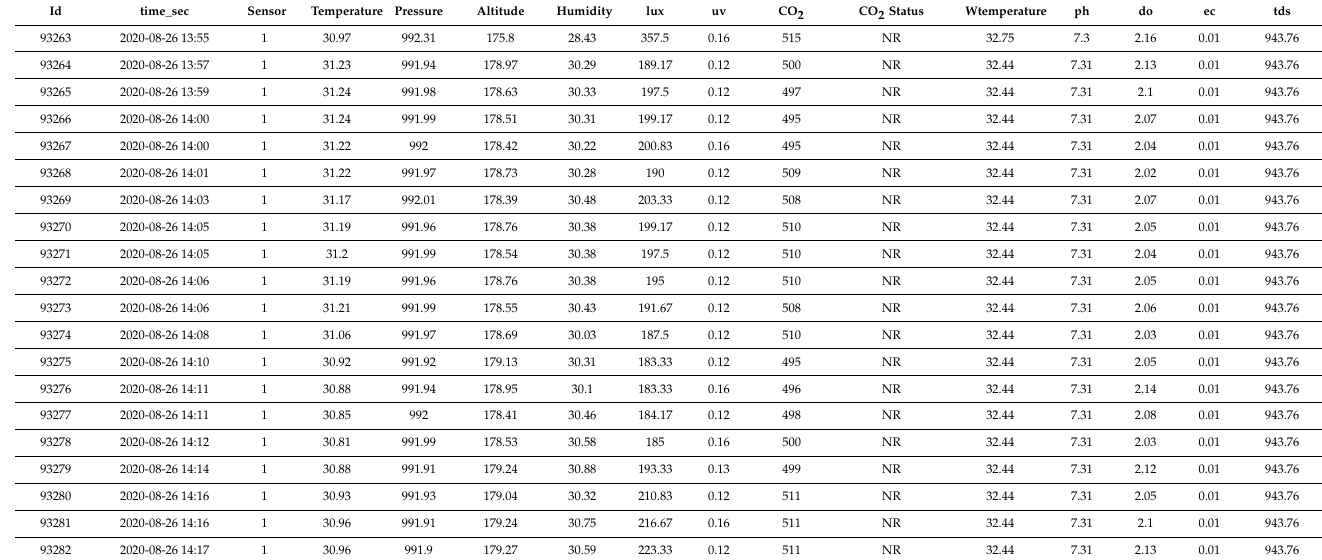
Table 5. Monitoring data of strawberry growing